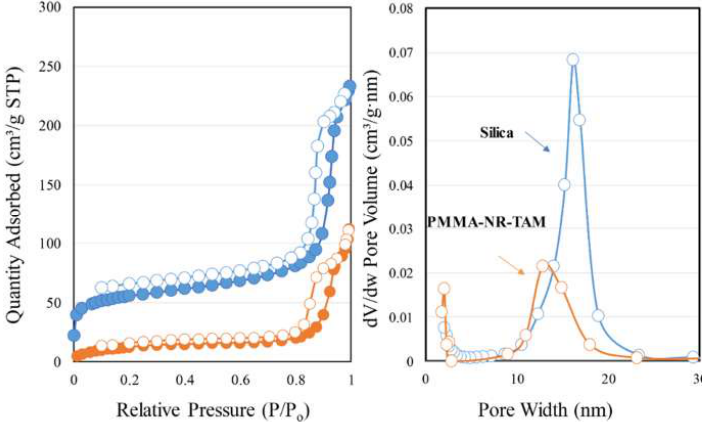
Figure 4. The surface area and pore size distributions of silica and PMMA-NR-Si-TAM.